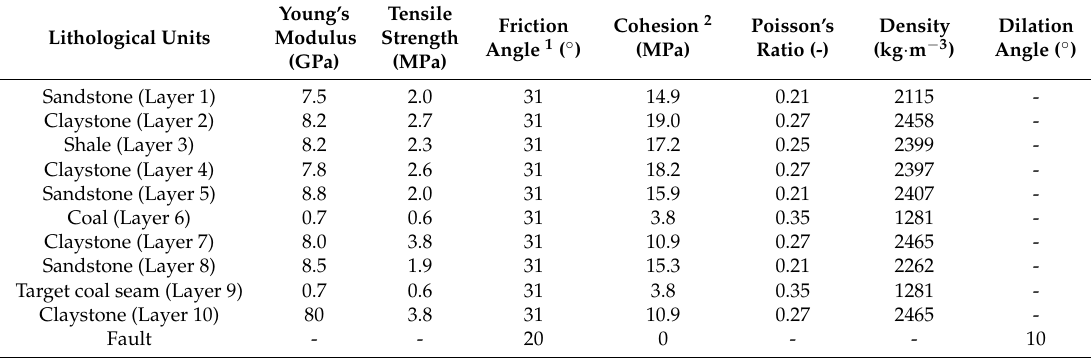
Table 1. Mechanical parameters used for all undertaken simulation runs (from Che´cko [34]).